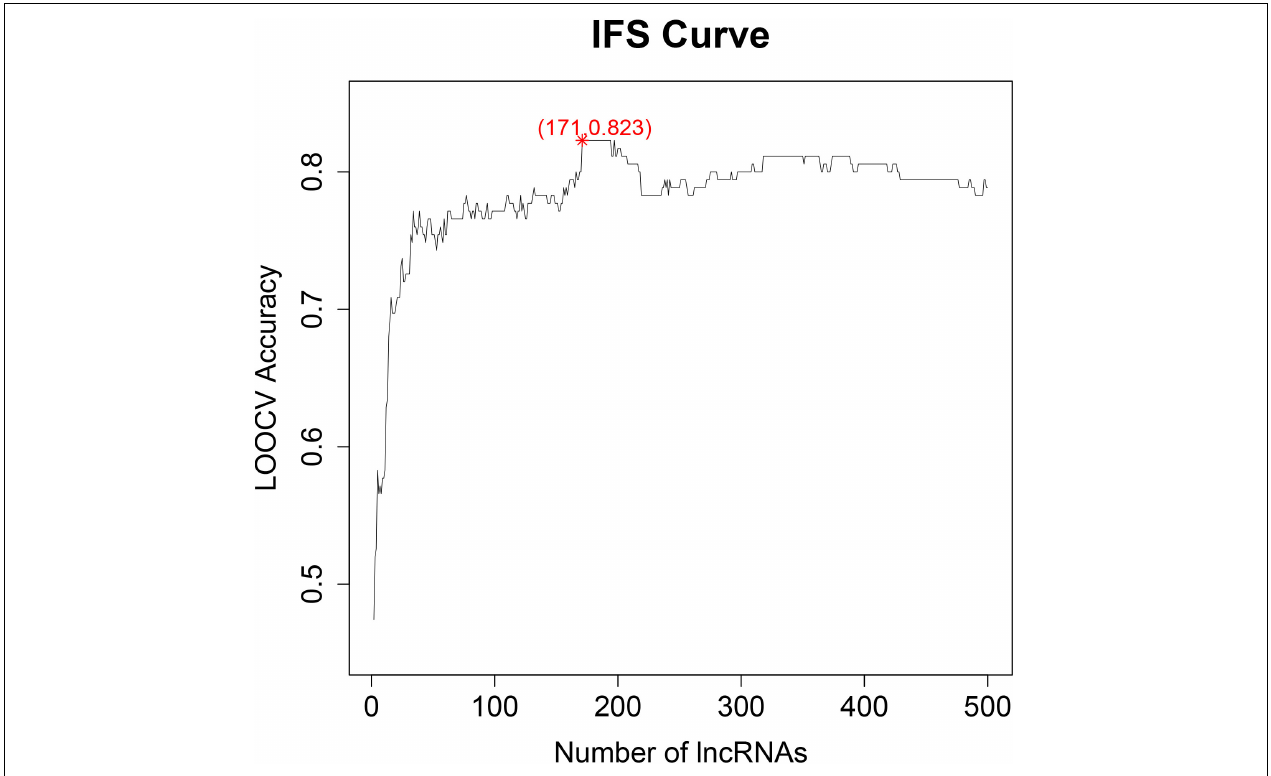
FIGURE 1 | The IFS curve for key lncRNA selection. The x -axis is the number of lncRNAs used to build the SVM classifier. The y -axis is the prediction accuracy evaluated with LOOCV. When 171 lncRNAs were used, the accuracy was the highest as 0.823. TABLE 1 | The confusion matrix of the prediction performance using 171 lncRNAs. Predicted stage 1 Predicted stage 2 Predicted stage 3 Predicted stage 4 Accuracy of each